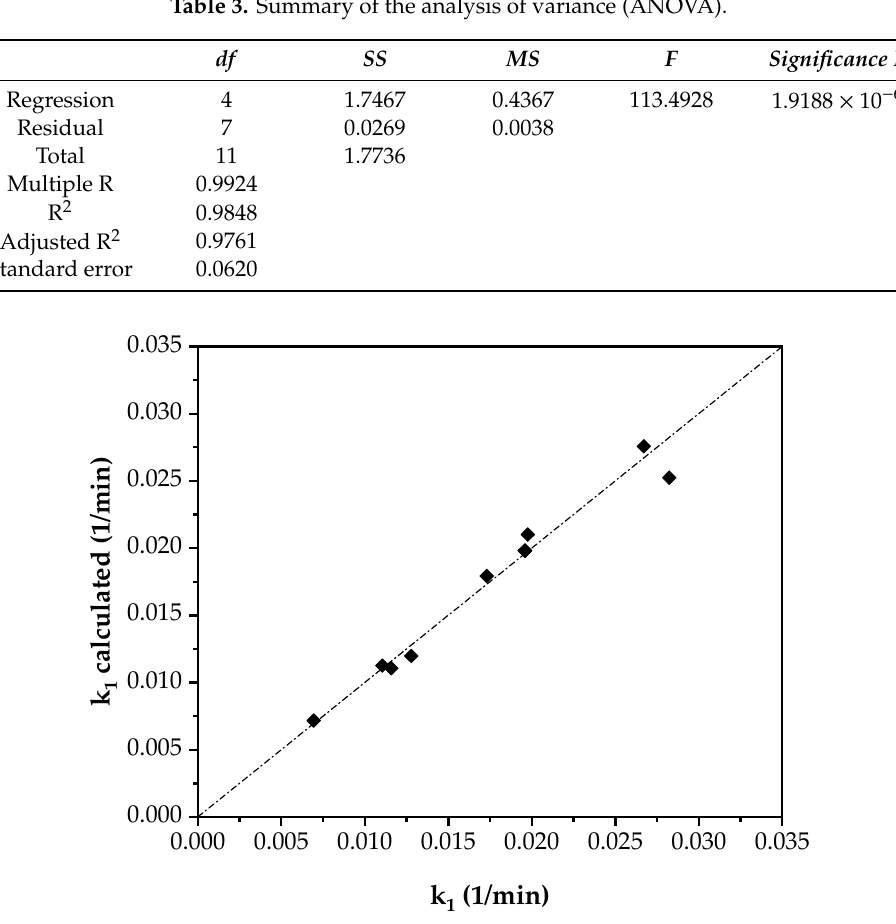
Figure 9. Comparison of observed and calculated value of k 1 .